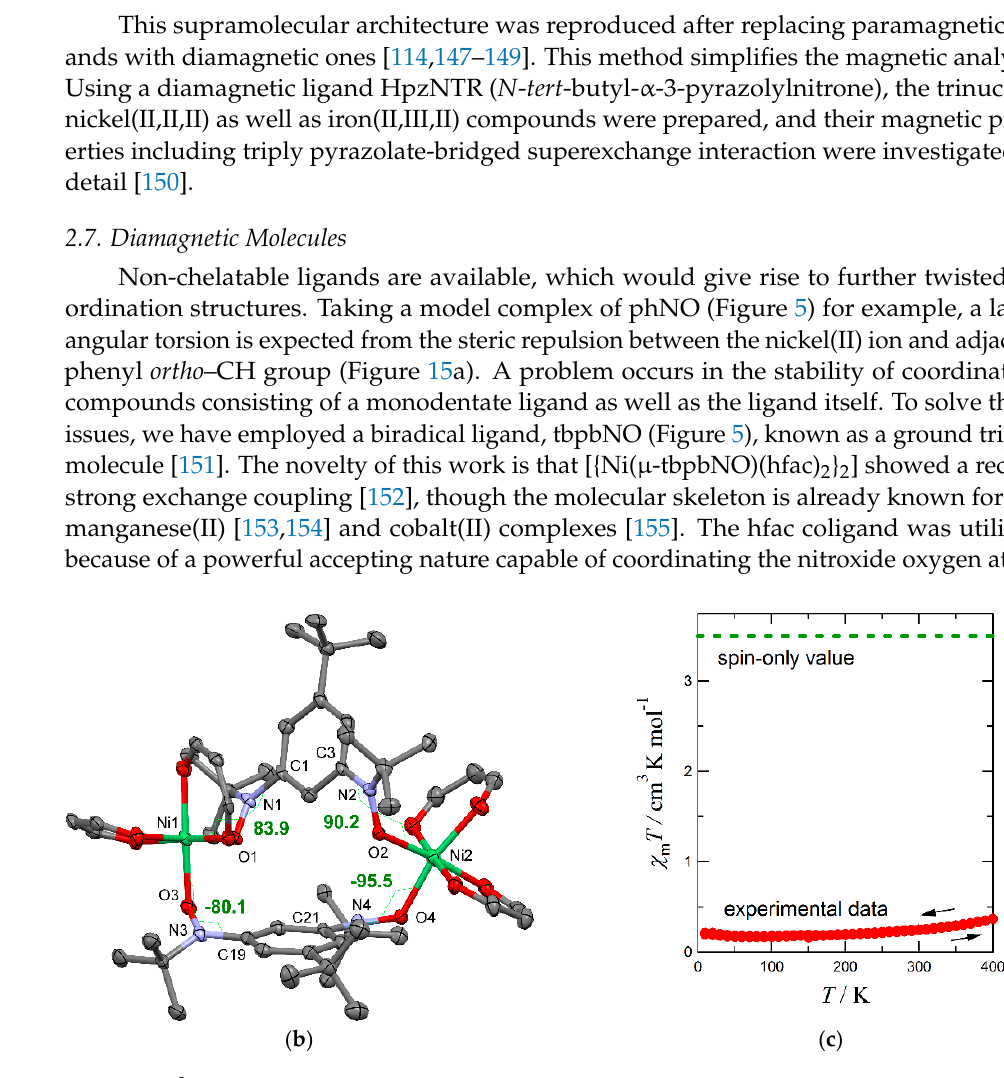
Figure 15. ( a ) Nonplanar Ni–O–N–C sp 2 structure caused by a bulky phenyl group. ( b ) X-Ray crystal structure of [{Ni( μ - tbpbNO)(hfac) 2 } 2 ] with thermal ellipsoids at the 50% probability level. Trifluloromethyl groups and hydrogen atoms are omitted. Selected atomic numbering and torsion angles ( φ (Ni–O–N–C sp 2 )) are indicated. ( c ) Temperature dependence of